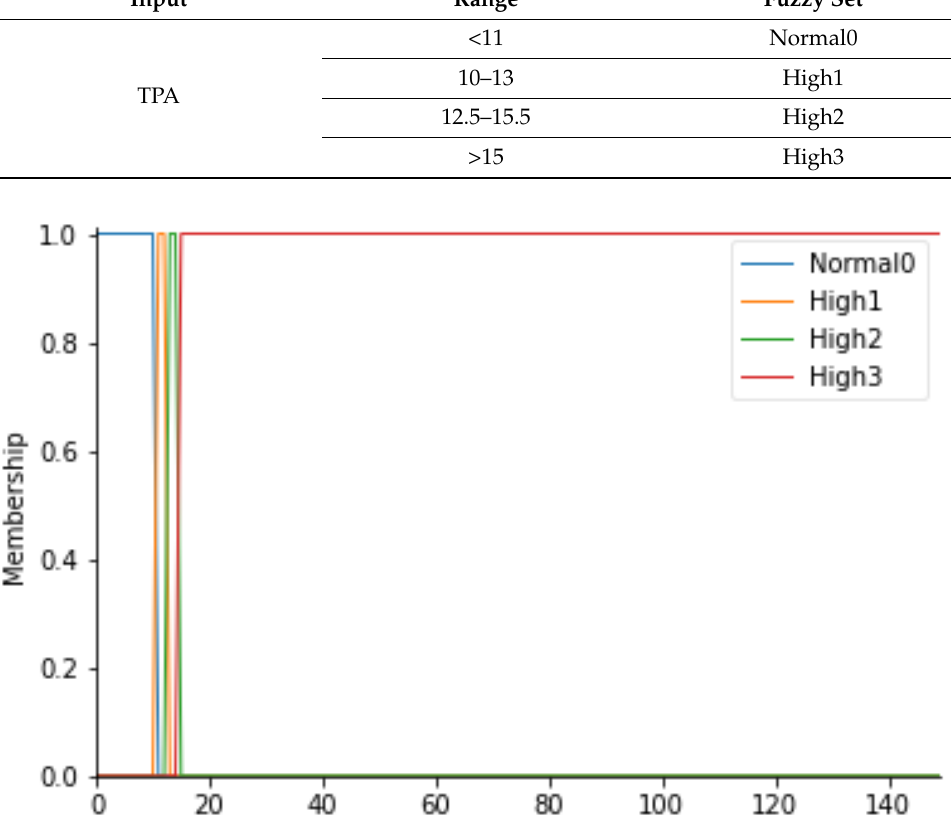
Figure 7. TPA membership functions.